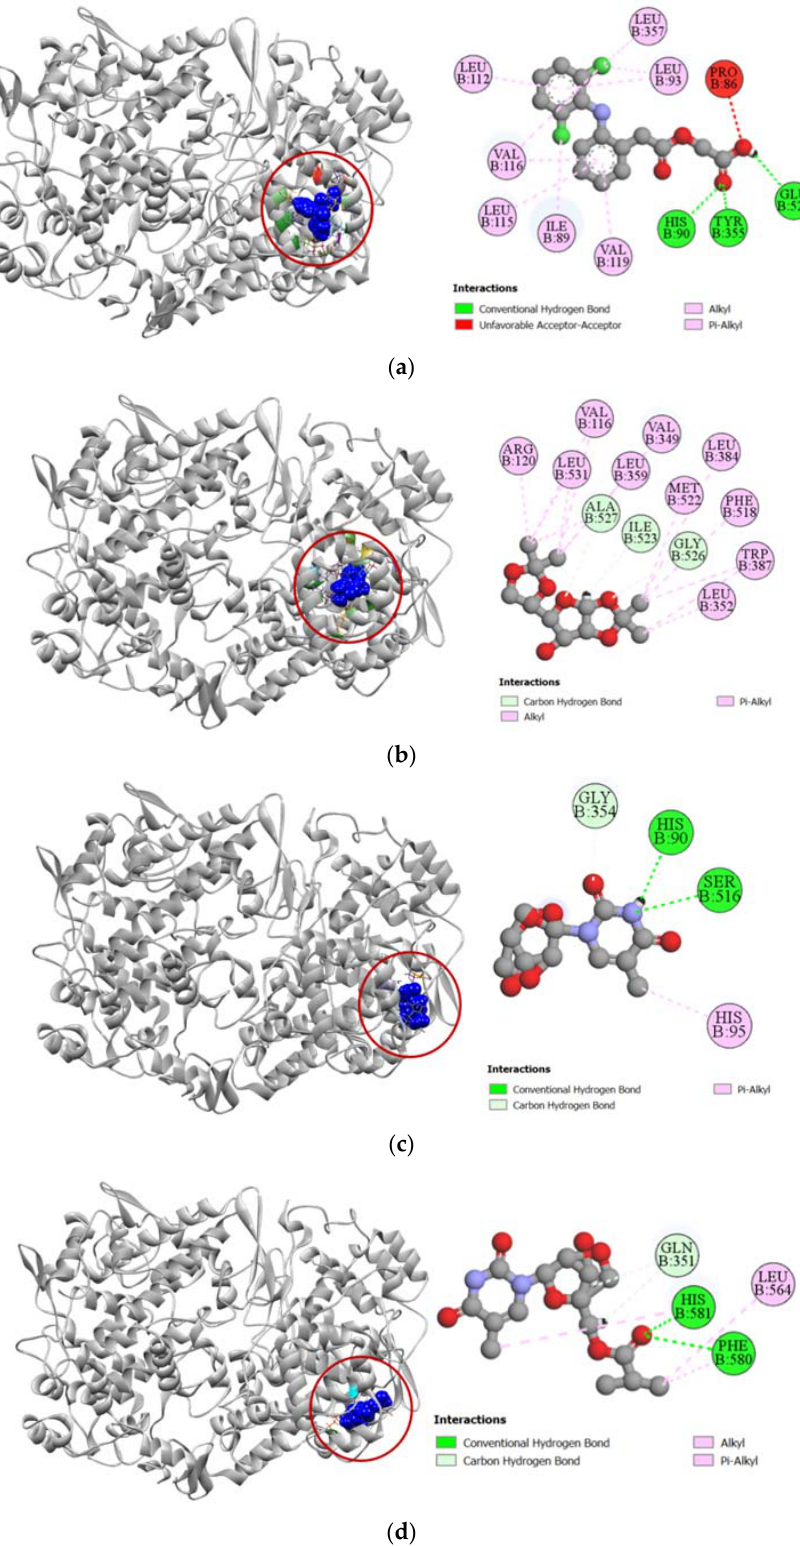
Figure 3. Pictorial representation (2D and 3D) of docking results for best-ranked pose of key inter- actions of ligands with the binding pocket of cyclooxygenase-1 (PDB: 1EQG). ( a ) Aceclofenac with 1EQG; ( b ) compound 2 with 1EQG; ( c ) compound 7 with 1EQG; ( d ) compound 8 with 1EQG.